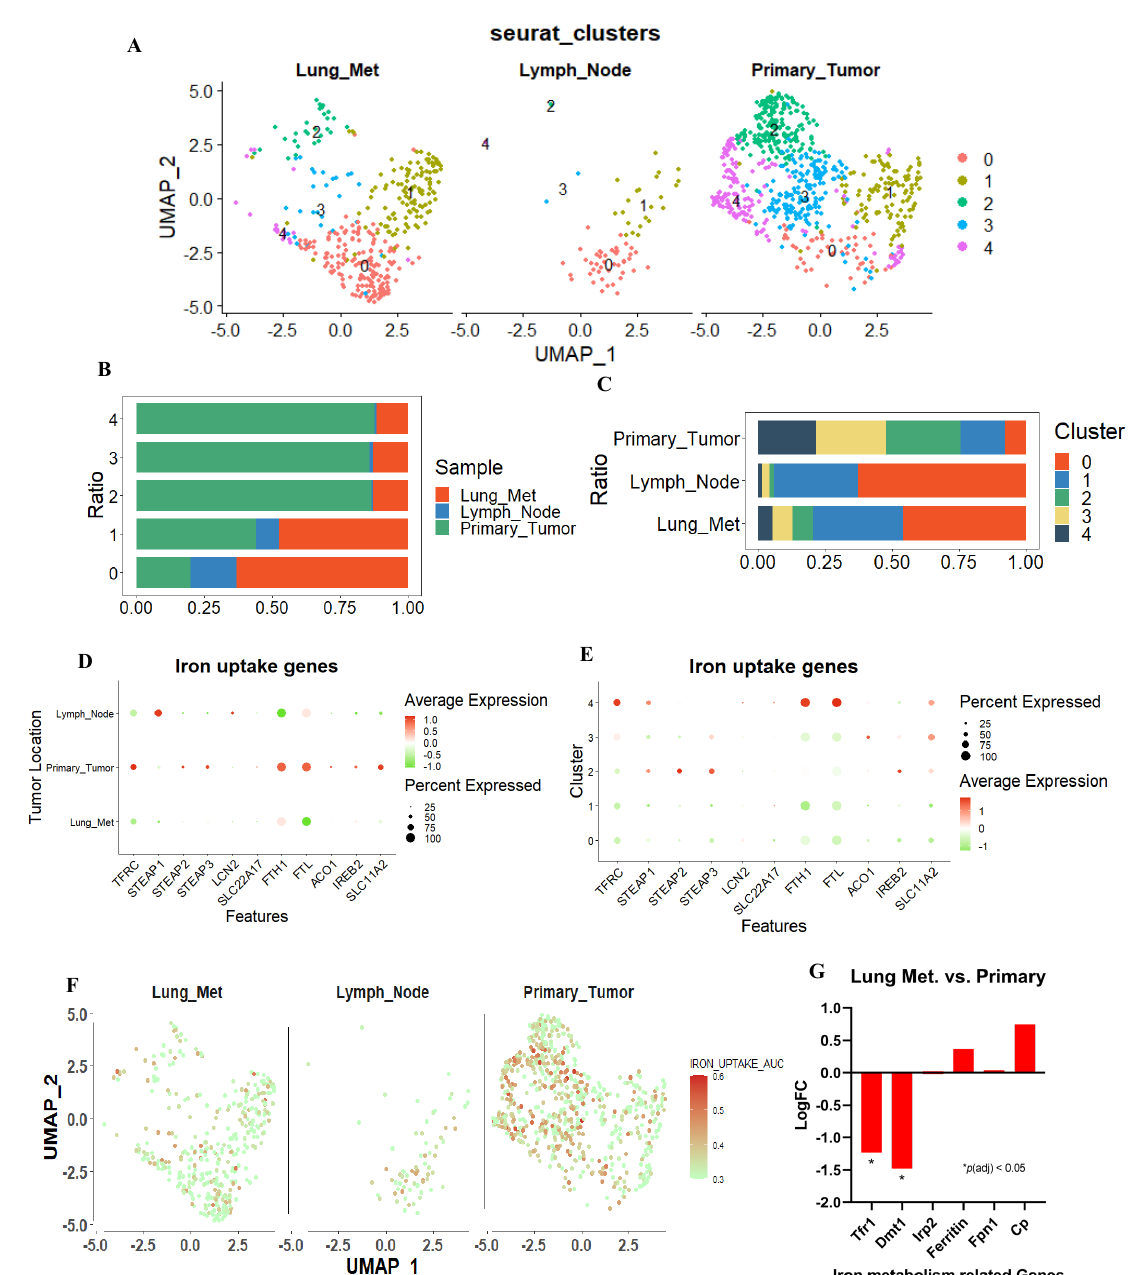
Figure 2. scRNA–seq analysis for TNBC–PDX tumor cells. ( A ) Uniform Manifold Approximation and Projection (UMAP) showing clustering of 1108 metastatic and primary tumor cells from the merged comprehensive data. Lung metastasis, lymph node metastasis, and primary tumor revealed different cluster pattern. ( B , C ) The proportion of tumor metastases and primary tumors within each cell cluster, and the proportion of tumor metastases and primary tumors within each cell cluster. ( D , E ) Dot plots were used to visualize iron–uptake genes, with the size of the dot representing the